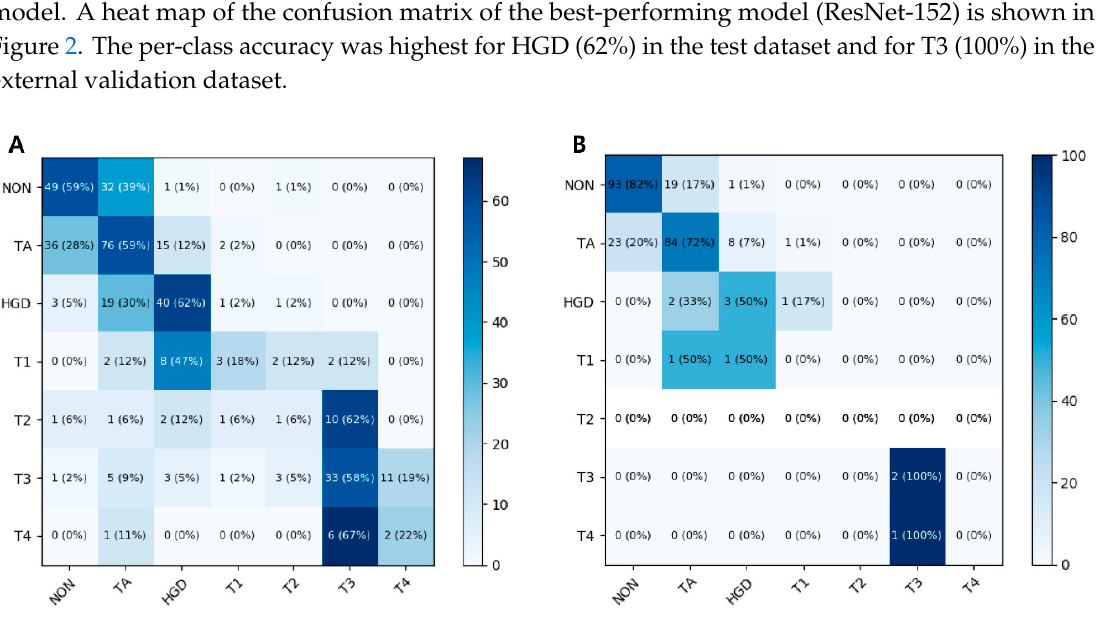
Figure 2. Heat maps of the ResNet-152 confusion matrices for seven-category classification scheme for colorectal lesions on colonoscopic photographs ( A ) in the test dataset and ( B ) in the external validation dataset. NON, non-neoplastic lesion; TA, tubular adenoma; HGD, high-grade dysplasia.